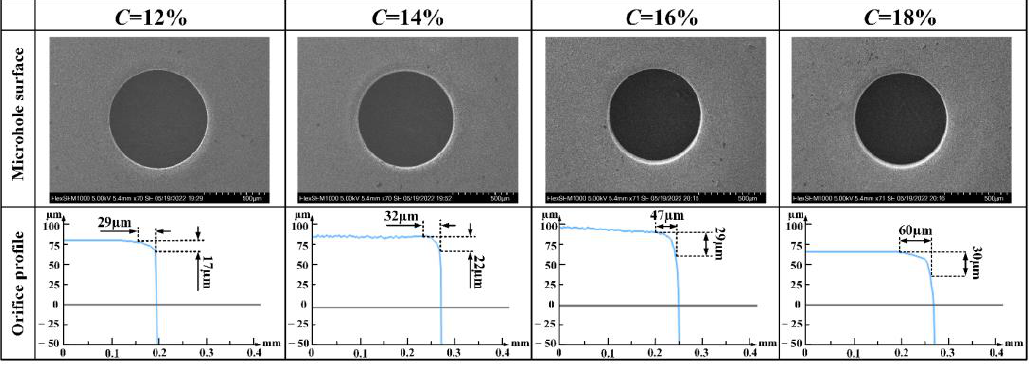
Figure 20. Effect of electrolyte concentration on orifice chamfer.